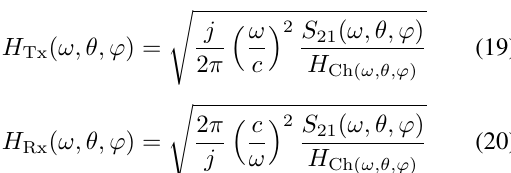
FIGURE 8: BER performance of the the overall system with/without the MIMO CPW-fed bent UWB antenna ( a ) CM1 case ( b ) CM2